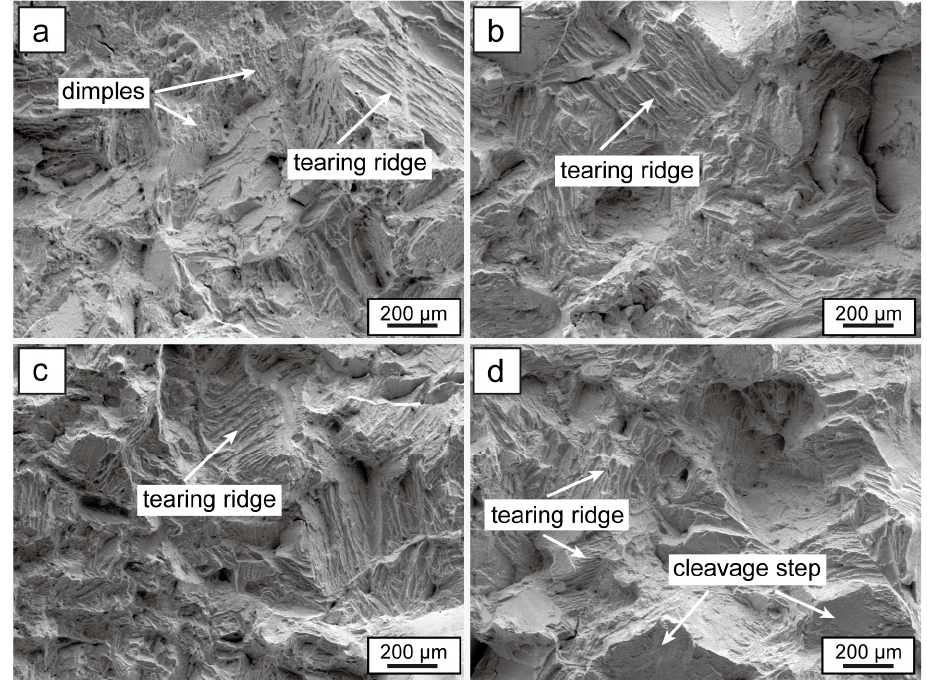
Figure 10. The SEM images of tensile fracture morphology for Ti6Al4V alloy modified and reinforced by Ti 5 Si 3 composite ribbon inoculants: ( a ) Ti6Al4V alloy matrix; ( b ) TMCs modified by 0.2 wt % inoculants; ( c ) TMCs modified by 0.4 wt. % inoculants; ( d ) TMCs modified by 0.6 wt. % inoculants.